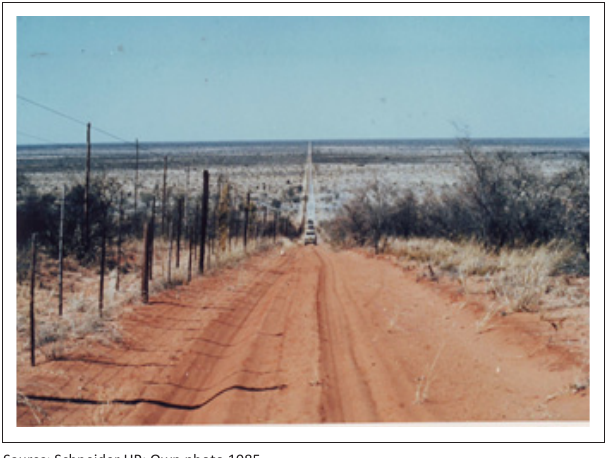
FIGURE 3: The Imperial Bacteriological Institute at Gammams (Windhoek) in 1897.